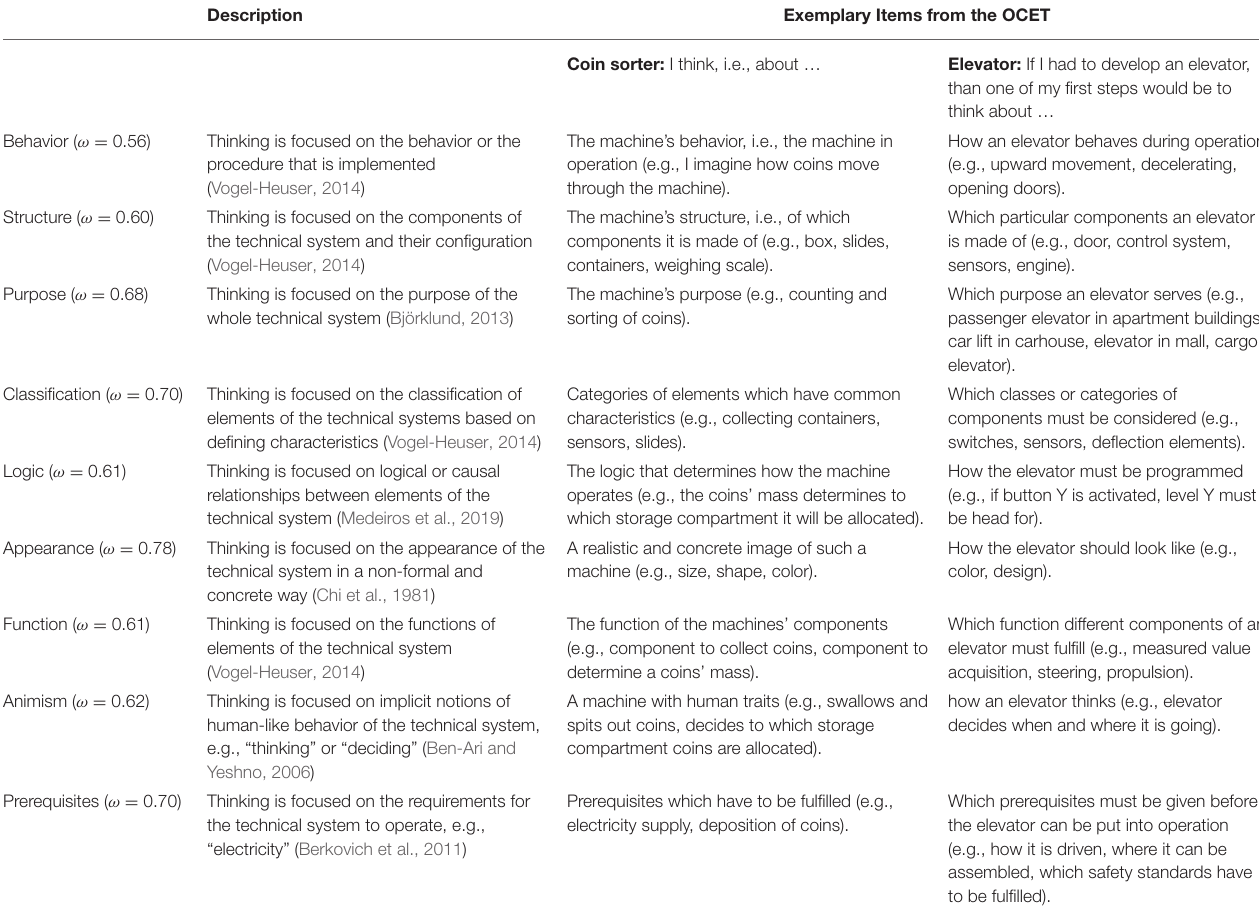
TABLE 2 | Nine ontological categories and their reliability, their descriptions, literature references, and two sample items from the Ontological Categories in Engineering Test (OCET).